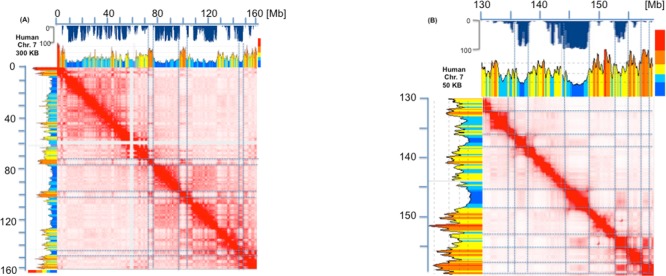
Heat map of chromatin interactions and isochores map of human chromosome 7.(A) The heat map of chromatin interactions of human chromosome 7 (from [3]) and the corresponding LAD map (from [7]; blue inverted profile under the Megabase axis) are compared with the corresponding compositional profile (using the matched b37 assembly of [3], and the program of [24]). The results are comparable with those of Fig 1A, except that the centromeric repeats (that have been sequenced in this chromosome) do not interact with any other sequence and are responsible for the two orthogonal blank stripes on the heat map. Blue lines correspond to TADs, LADs and inter-LADs. (B). The heat map of chromatin interactions over ~30 Mb of human chromosome 7 is analyzed at a resolution of 50 Kb. In this case a finer correspondence of isochore boundaries with LAD and TAD boundaries can be observed.